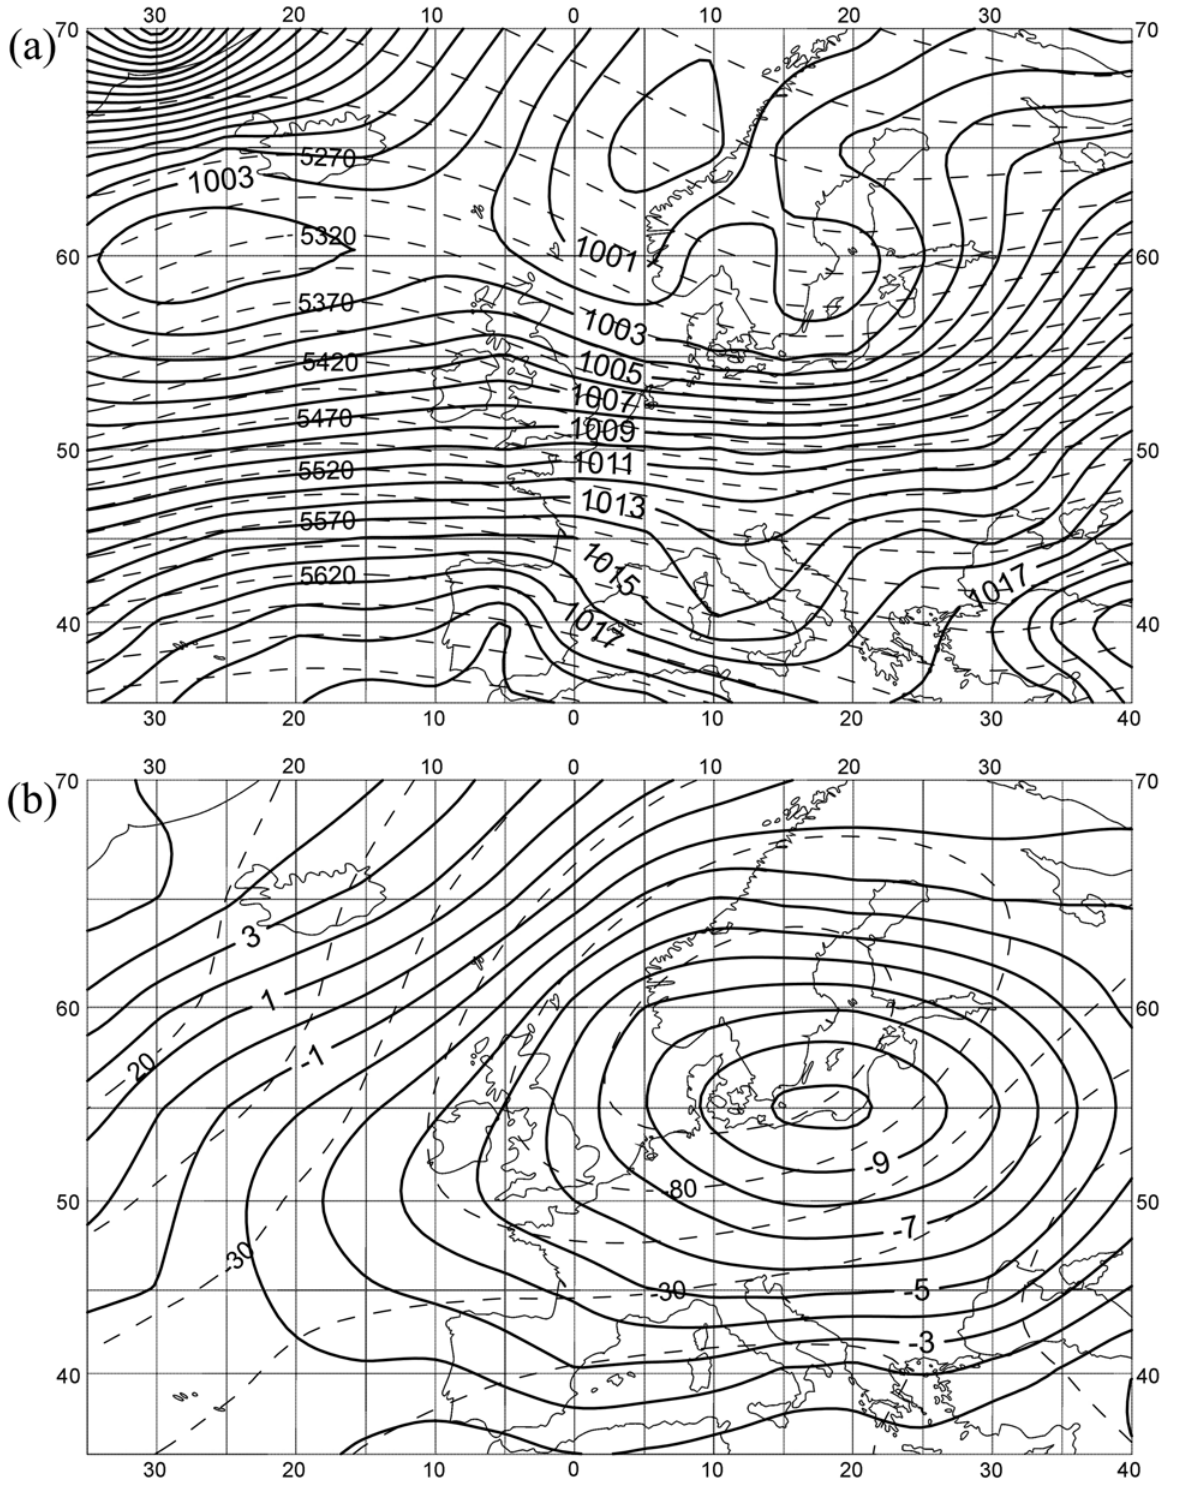
Fig. 7. Mean sLP (in hPa) and z500 hPa (in gpm) during the christmas period (a) and sLP (in hPa) and z500 hPa (in gpm) anomalies (b) in type